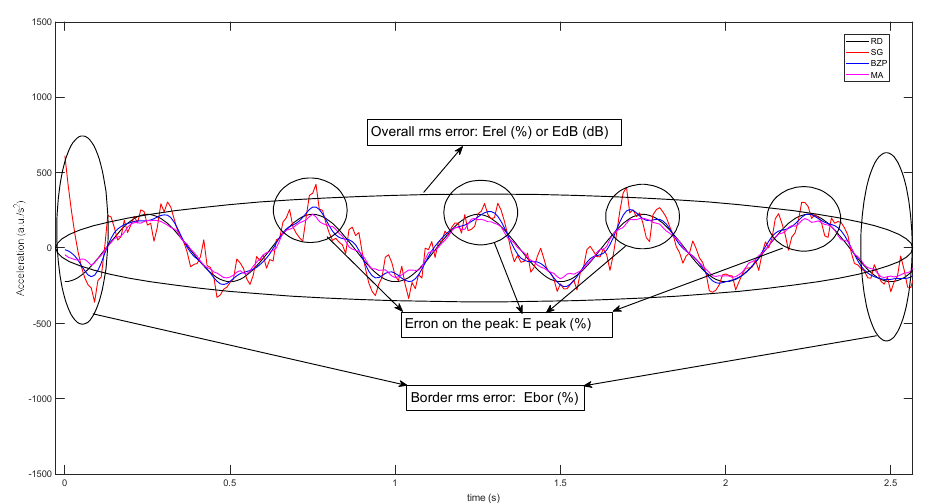
Figure 13. Error parameters to evaluate differentiation/filtering procedures and their evaluation zones on signal time his- tory.